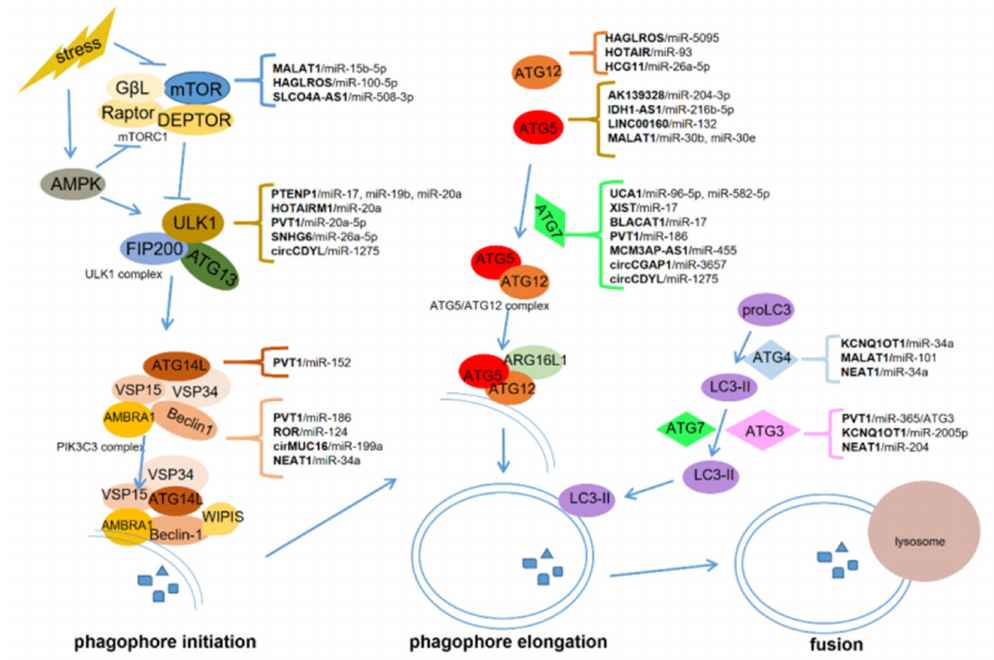
Figure 1. Competing endogenous RNAs (ceRNAs) regulate autophagy in cancers. ceRNAs regulate autophagosome initiation or phagophore elongation by upregulating mTOR, ULK1, ATG13, ATG14L and Beclin-1, or ATG12, ATG5, ATG7, ATG4, and ATG3,